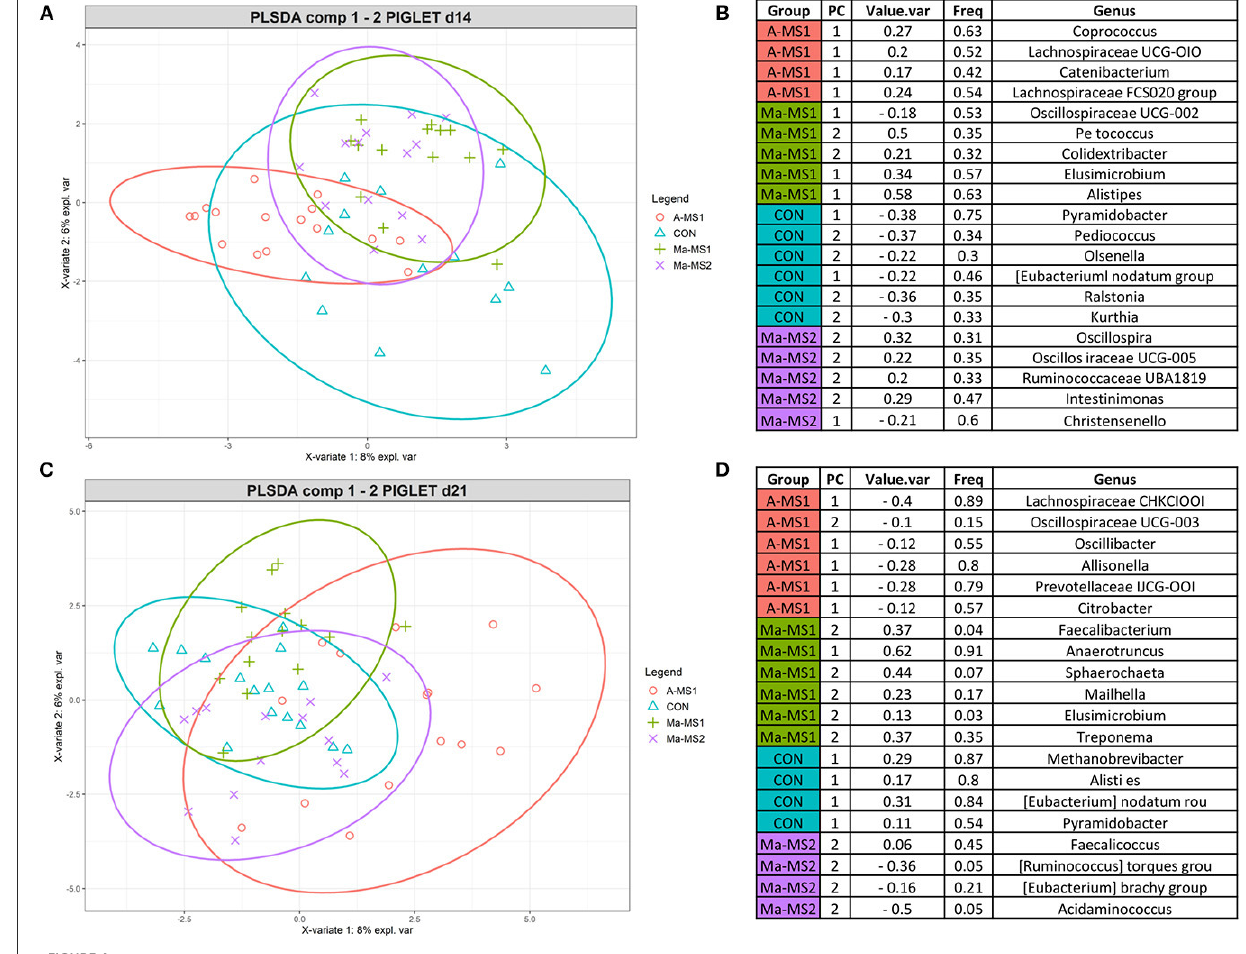
FIGURE4 Results of the PLS-DA analysis on fecal microbiota of piglets at d14 (A, C) Individual score plots of the samples along the first two components at d14 (A) and d21 (C) . (B, D) Table reporting the most discriminant genera per group at d14 (B) and d21 (D) ; Value.var expresses the variance explained by the single genera; Freq, express the frequencies by which the genera were chosen among the 100 repetitions of the cross validation; PC stands for the principal component that discriminate the genera; Group express the group for which the genera were discriminant. CON, control group without milk supplementation; A-MS1, MS1, provided automatically; Ma-MS1, MS1, provided manually twice a day; Ma-MS2, MS2, provided manually twice a